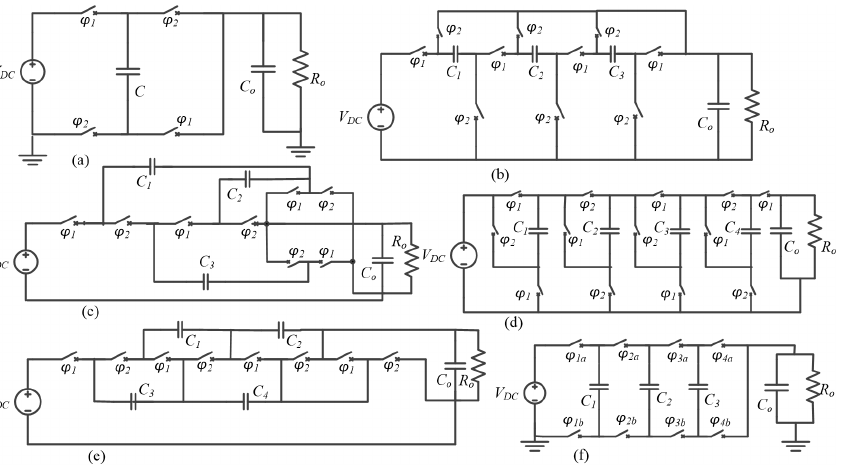
Figure 4. Step-down converters based on the switched-capacitors; ( a ) 2-to-1, ( b ) series-parallel (4-to-1), ( c ) Dickson (4-to-1), ( d ) Fibonacci (5-to-1), ( e ) ladder (4-to-1) and ( f ) flying-capacitor multilevel (4-to- 1)